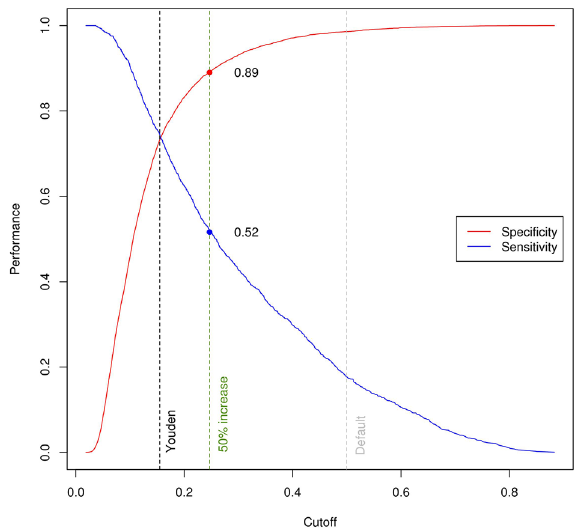
Figure 2. Specificity (blue) and sensitivity (red) values across all possible thresholds for all operations combined. The default 0.50 threshold is marked in grey, the threshold based on the maximized Youden index in black, and the threshold representing a 50% increase in mortality risk in green.